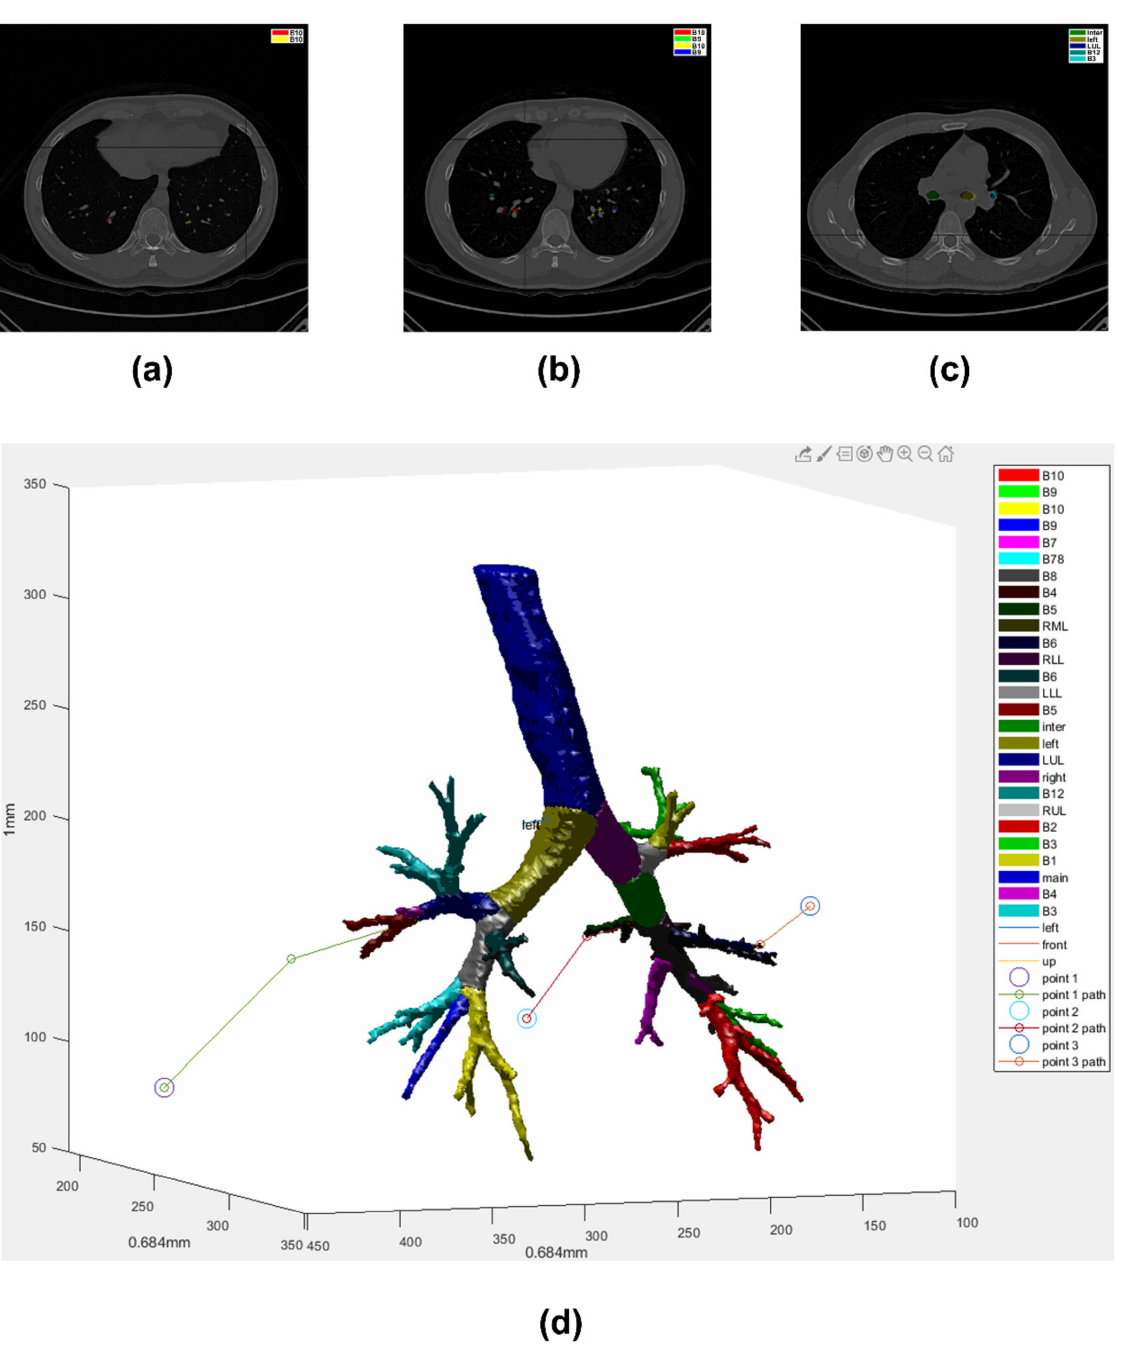
Figure 12. Attribution test. ( a ) Test point 1; ( b ) test point 2; ( c ) test point 3; ( d ) 3D graphics file mapping